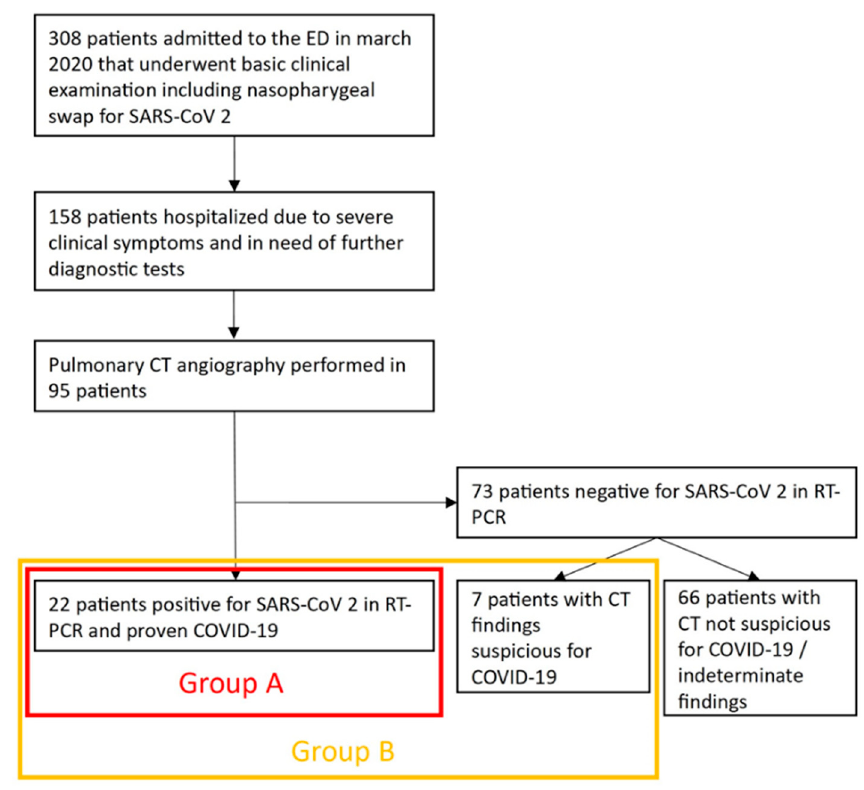
Figure 1. Flowchart of patients included in the study.